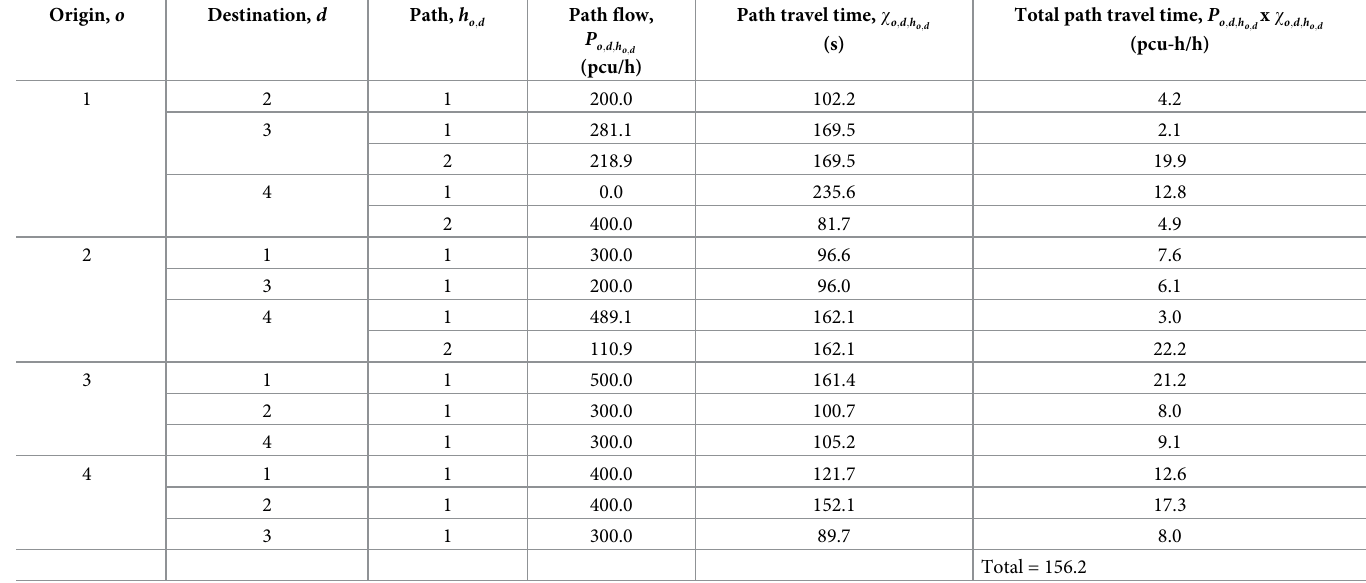
Table 8. Details of path flows and path travel times by the proposed algorithms. Origin,